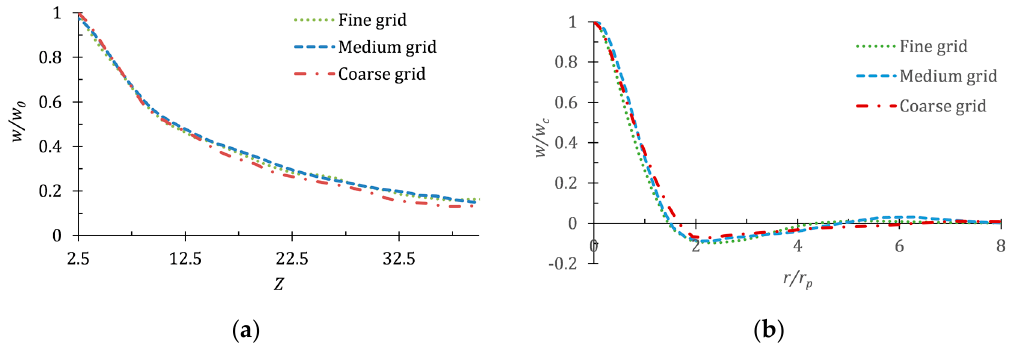
Figure 6. Mesh refinement study. ( a ) Vertical velocity decay of the jet axis in Case A0. ( b ) Vertical velocity profiles of jets at the pycnocline in Case A9.